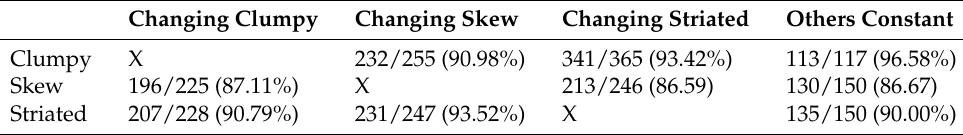
Table 2. Results from user study 2. Entries are read as RIGHT/TOTAL (% Correct).